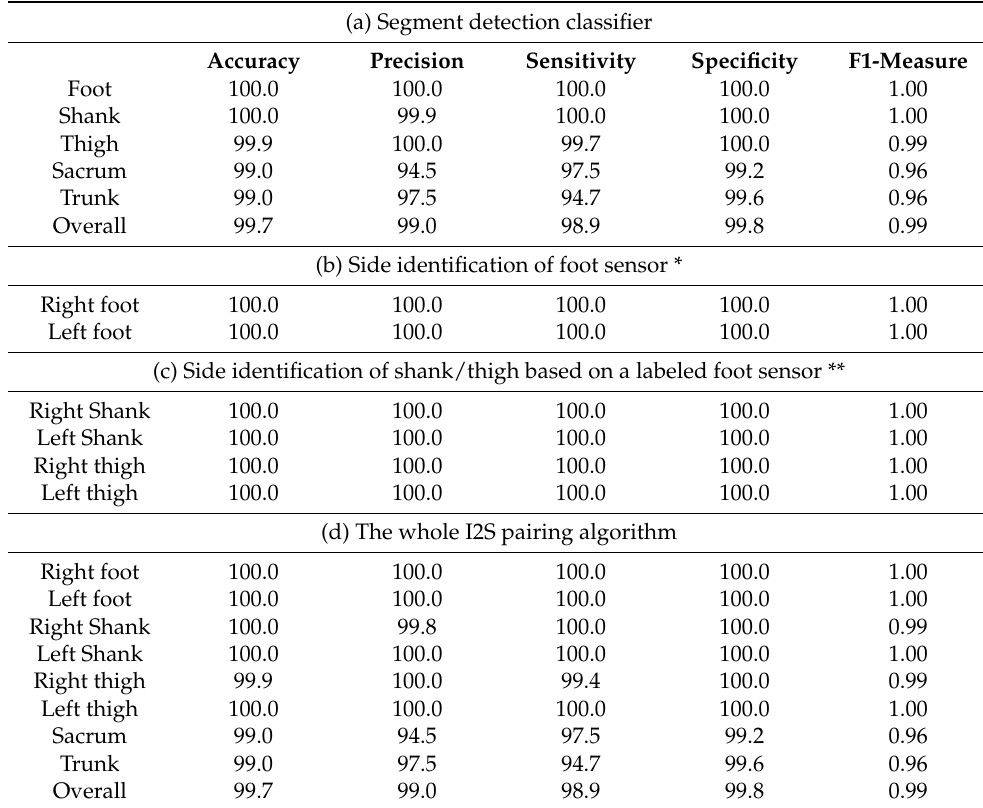
Table 2. The performance of the decision tree classifier (a) for the segment detection (b) for side identification of feet sensors, (c) for side identification of the shank and thigh, and (d) for the whole I2S pairing algorithm. For (b) and (c), the accuracy is reported based on the correct input of each part, i.e., the input for the side detection of the foot sensor was only feet